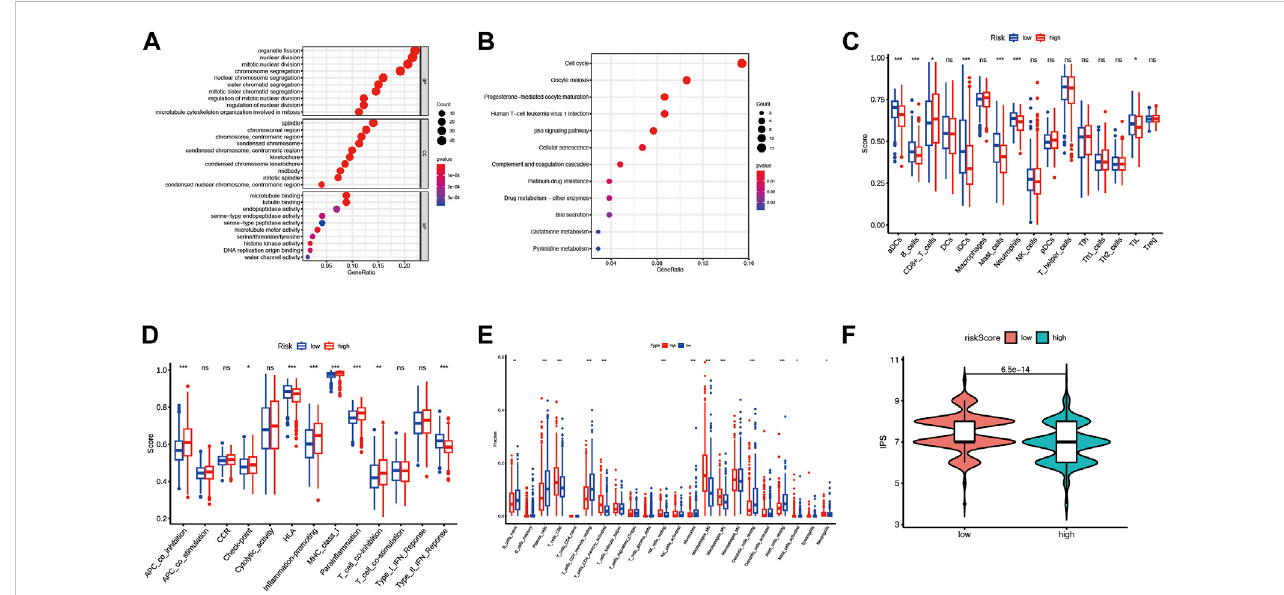
FIGURE 8 The differences in the immune environment between the high and low-risk groups of the merge cohort. (A) The GO enrichment result for differential expression genes between the high and low-risk group. (B) The KEGG enrichment result for differential expression genes between the high and low-risk group. (C) 16 immune cellsignatureswerecompared between thehighandlow-riskgroups. (D) 13 immune functionsignatureswerecompared betweenthe high and low-risk group I (E) immune cell fractions inferred by CIRBERSORT were compared between the high and low-risk groups. (F) Immunephenoscore(IPS)wascomparedbetweenhigh andlow-risk groups.Thesymbols*,**,***,***correspondedto p < .05,.01,.001,.0001,respectively. p < .05 was regarded as signi fi